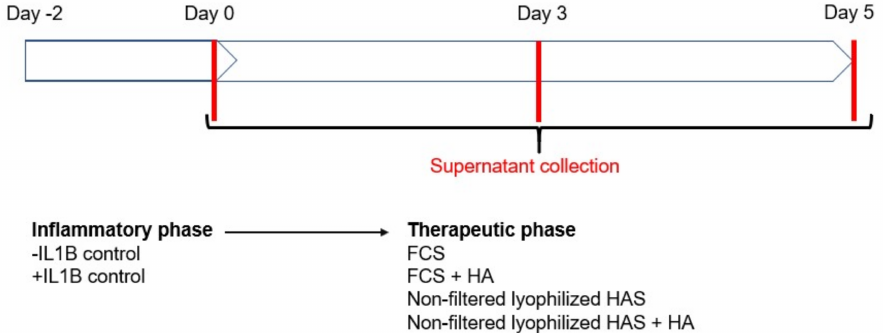
Scheme 1. Experimental design of the inflammatory co-culture model experiment. The schematic represents the timeline and the conditioning medium that was used in each phase. Abbreviations: fetal calf serum (FCS), hyperacute serum (HAS), hyaluronic acid (HA), interleukin 1 beta (IL-1 β ).